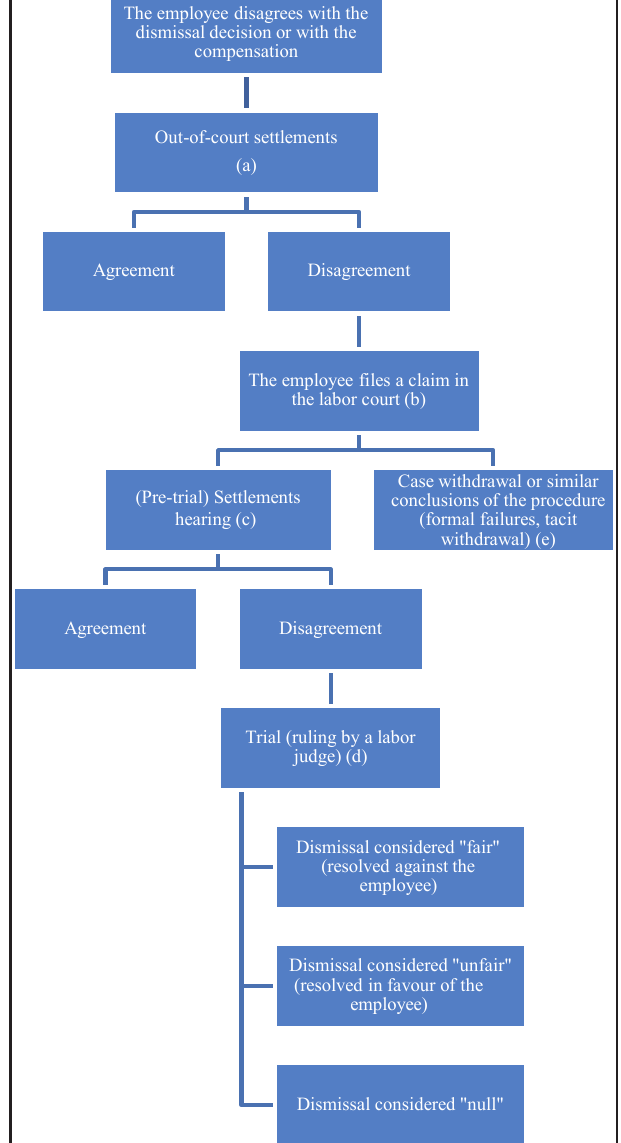
Figure 1 Layoff procedure in the Spanish labor jurisdiction. The employee disagrees with the dismissal decision or with